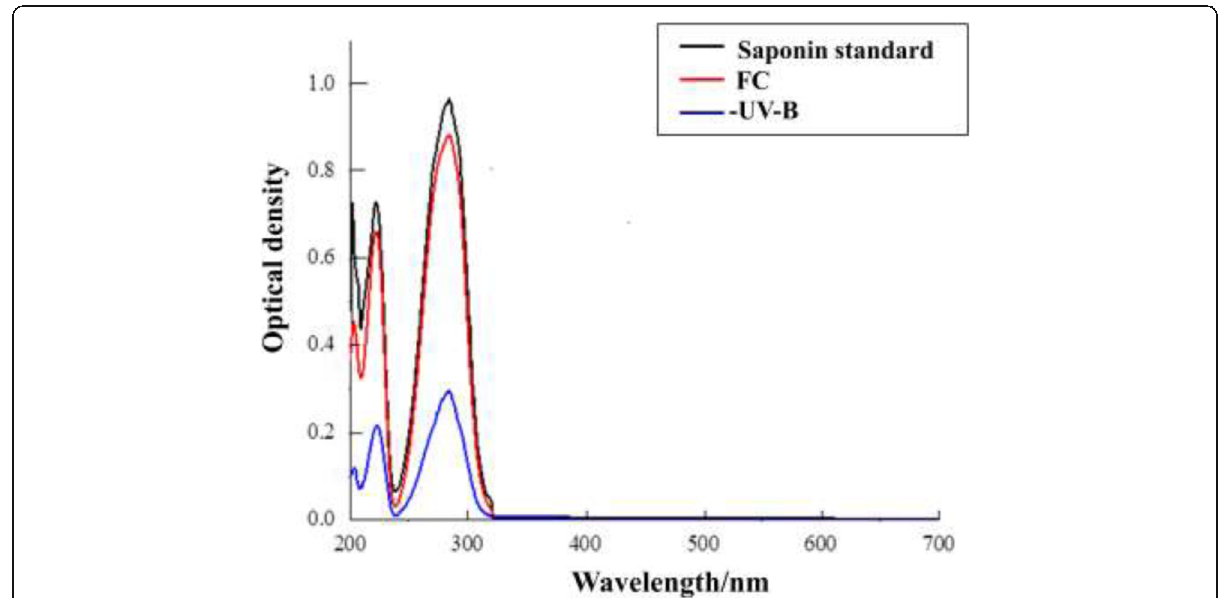
Fig. 5 Overlay UV absorption spectra of saponin standard and the corresponding band in the sample extracted from leaves of cotton var. Vikram plants grown in filter control and UV-B excluded conditions. (Spots were scratched from TLC plate at Rf 0.285 and dissolved in 50% methanol)